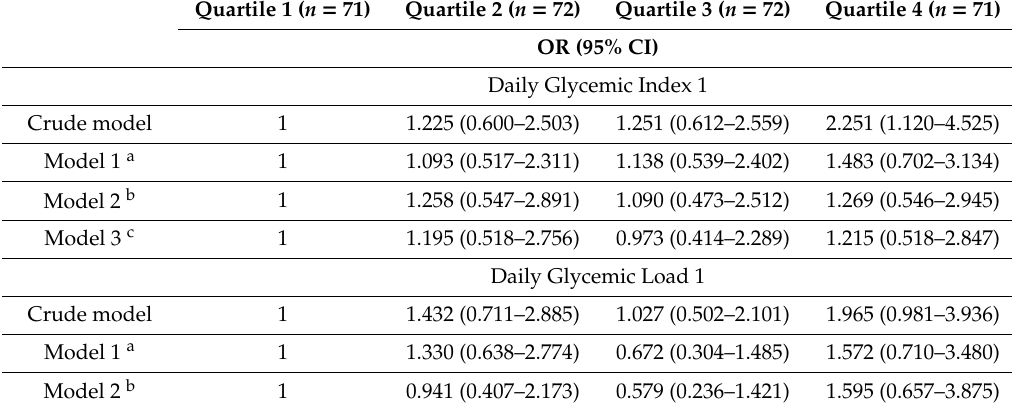
Table 3. Multivariable logistic regression analyses of MetS by dietary GI 1 and GL 1 quartiles. Quartile 1 ( n =